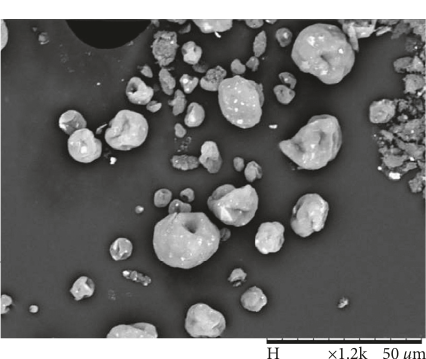
Figure 6: Optimised spray-dried YSZ-aerogel powder measured by SEM with a top surface view with a magnification of ×